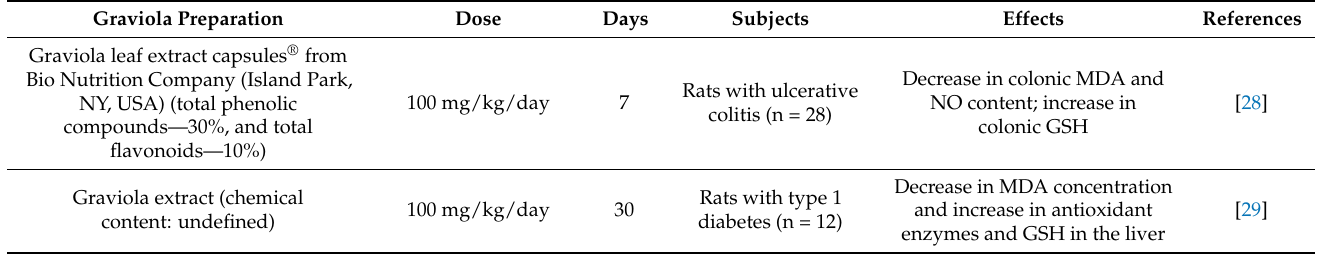
Table 1. The antioxidant potential of graviola preparation in in vivo